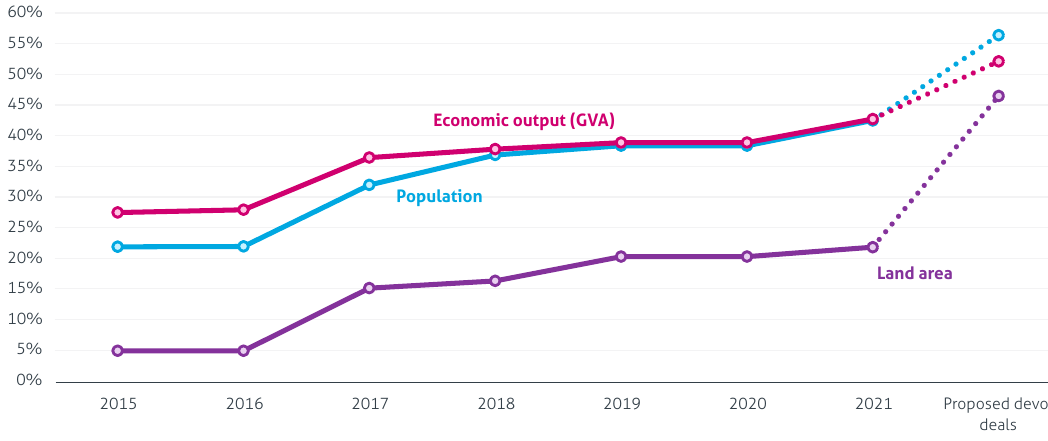
Figure 5 How much of England is covered by current and proposed devolution deals?